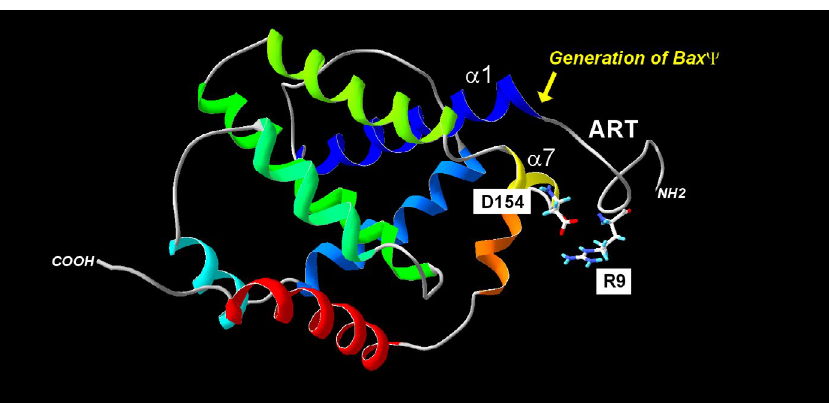
Figure 2. Regulation of Bax mitochondria localization by the ART. The absence of the ART (20 N-terminal residues) generates the BaxΨ variant, which is spontaneously mitochondrial and active. Within the ART, the R9 residue may interact with the residue D154 of helix α7. Point mutations in the helix α1 decrease the mitochondrial localization of both wild-type Bax (BaxWT) and BaxΨ. Together, these data suggest that a movement of ART away from the core of the protein may contribute to the exposure of helix α1 to mitochondrial Table 2. Mutational analysis of the N-terminus of Bax in yeast and mammalian models [121, 126, 133, 134] Sequence Protein Binding to mitochondria Cytochrome c release Yeast Mammals Yeast Mammals full length Bax +/-